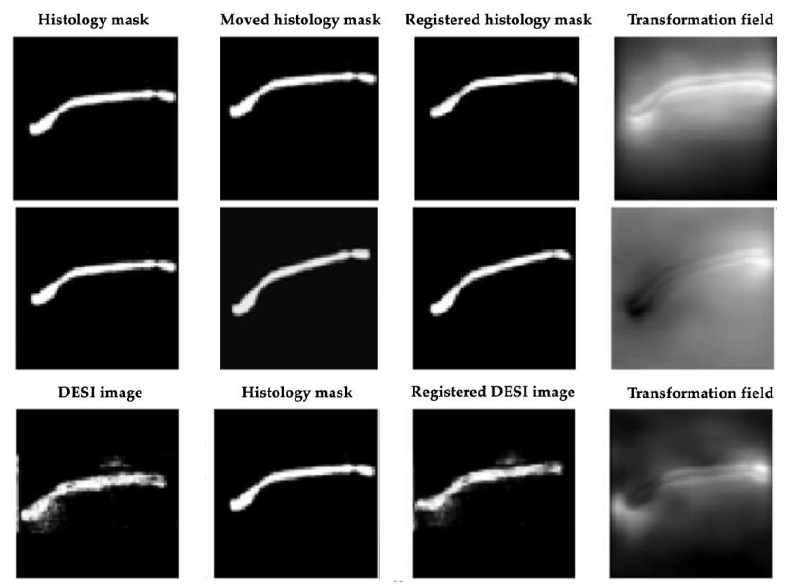
Figure 10. MassReg registration results after training experiment 1. Row 1 — Simulated unregistered pair (translation). Row 2 — Simulated unregistered pair (rotation). Note — the registered histology mask in column 3 of rows 1 and 2 should be identical to the moved histology mask in column 2, as observed. Row 3 — Real unregistered pair. The registered DESI image should be spatially aligned with the histology mask in column 2. In this registration, the DESI image is not moved close enough to the right or shifted enough vertically.